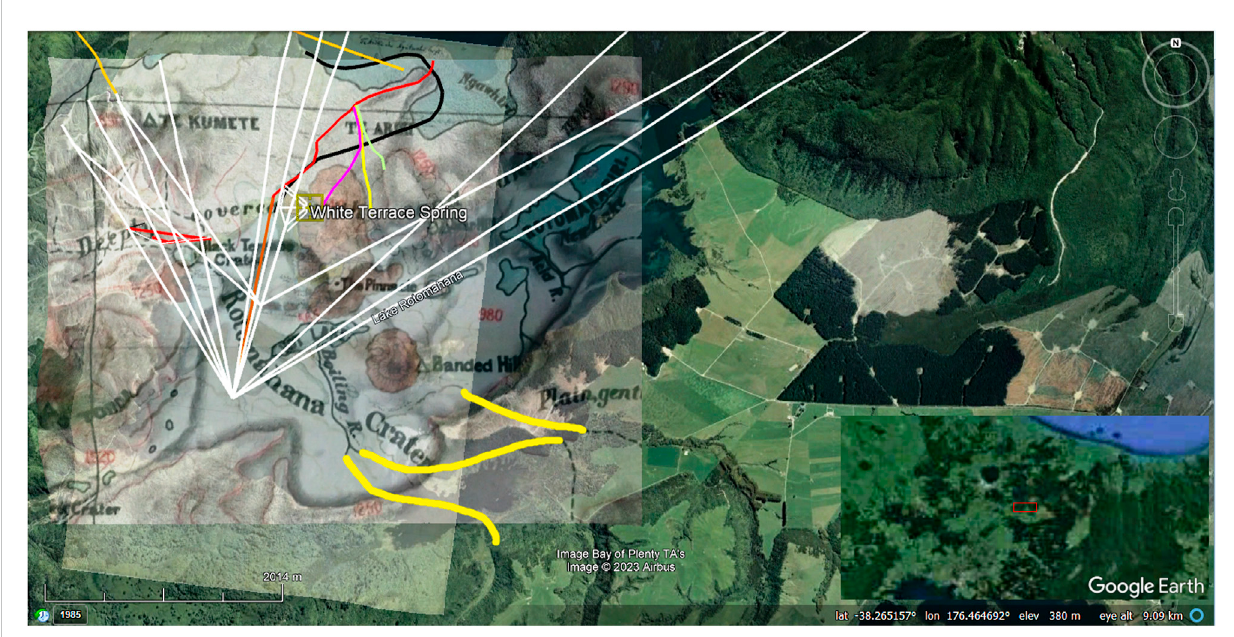
FIGURE 10 Georeferencing showing the Boiling River branches in Smith ’ s 1886 map superimposed over Hangapoua Stream on Hochstetter ’ s 30 April map. It connects with streams 1283784 and 1283810. The Waiahinekahu connects to the existing stream 1102186. Note the three eastern gullies, issuing these streams then and now. The overview map marks the location in the northern Taup ō Volcanic